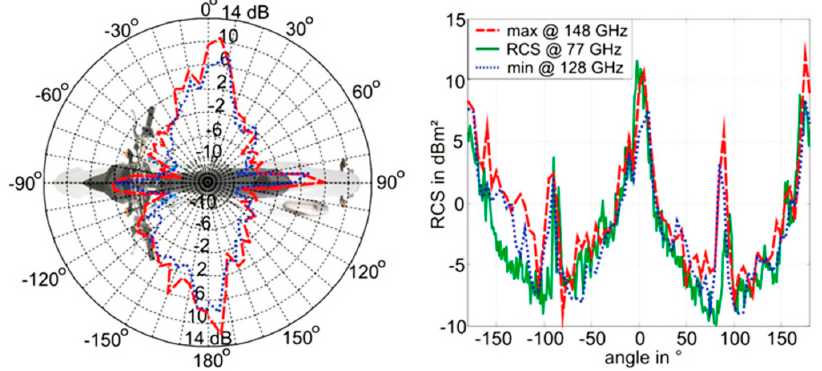
Figure A1. Radar Cross-Section of a motorcycle. Adapted from (Köhler et al. 2013) [119].